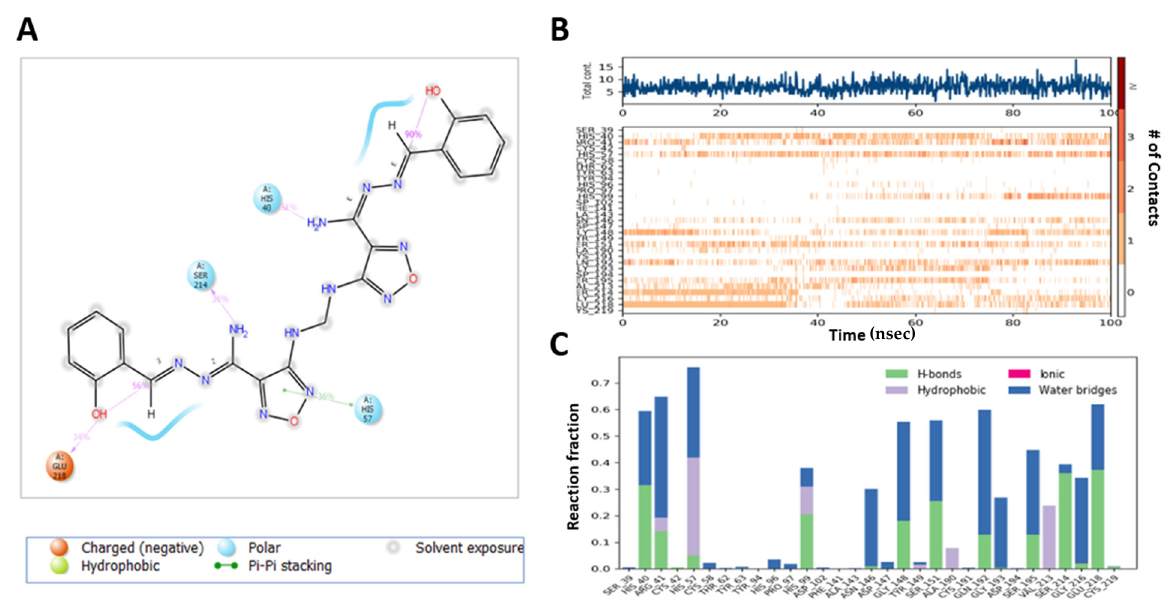
Figure 13. Interaction diagram of Compound 13 with TMPRSS2 observed during the molecular dynamic simulation. ( A ) The protein–ligand interaction diagram. ( B ) The top panel showed the specific contact of TMPRSS2 protein with Compound 13 in each trajectory course, the bottom panel showed the amino acid residues that interact with the ligand in the trajectory time frame. The residues making more than one contact were shown in a darker color shade. ( C ) Schematic diagram of ligand interaction with the amino acid residues of protein during MD simulation.